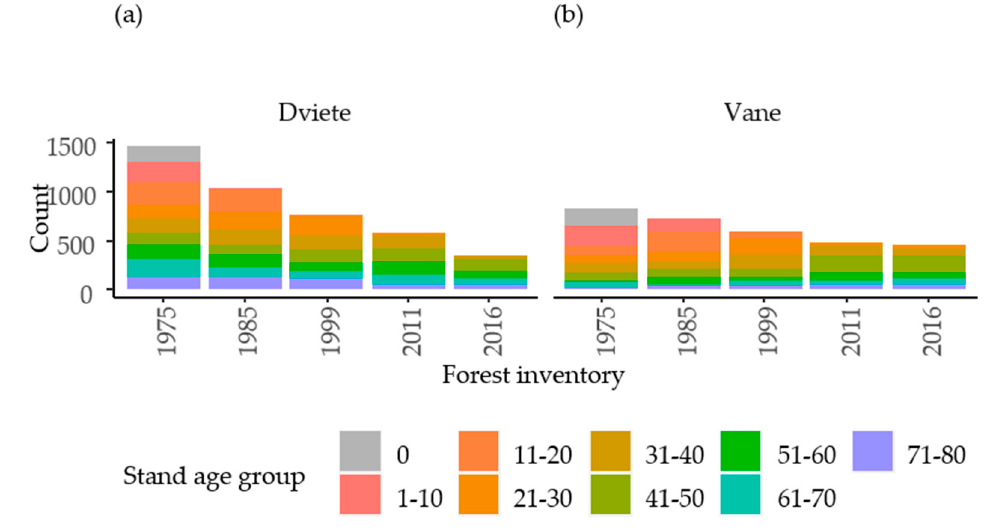
Figure 4. The dynamics of successfully transitioned Norway spruce stands (core areas) between inventories in two forested landscapes, Dviete ( a ) and Vane ( b ), respectively (only those stands that survived throughout the entire period are displayed).